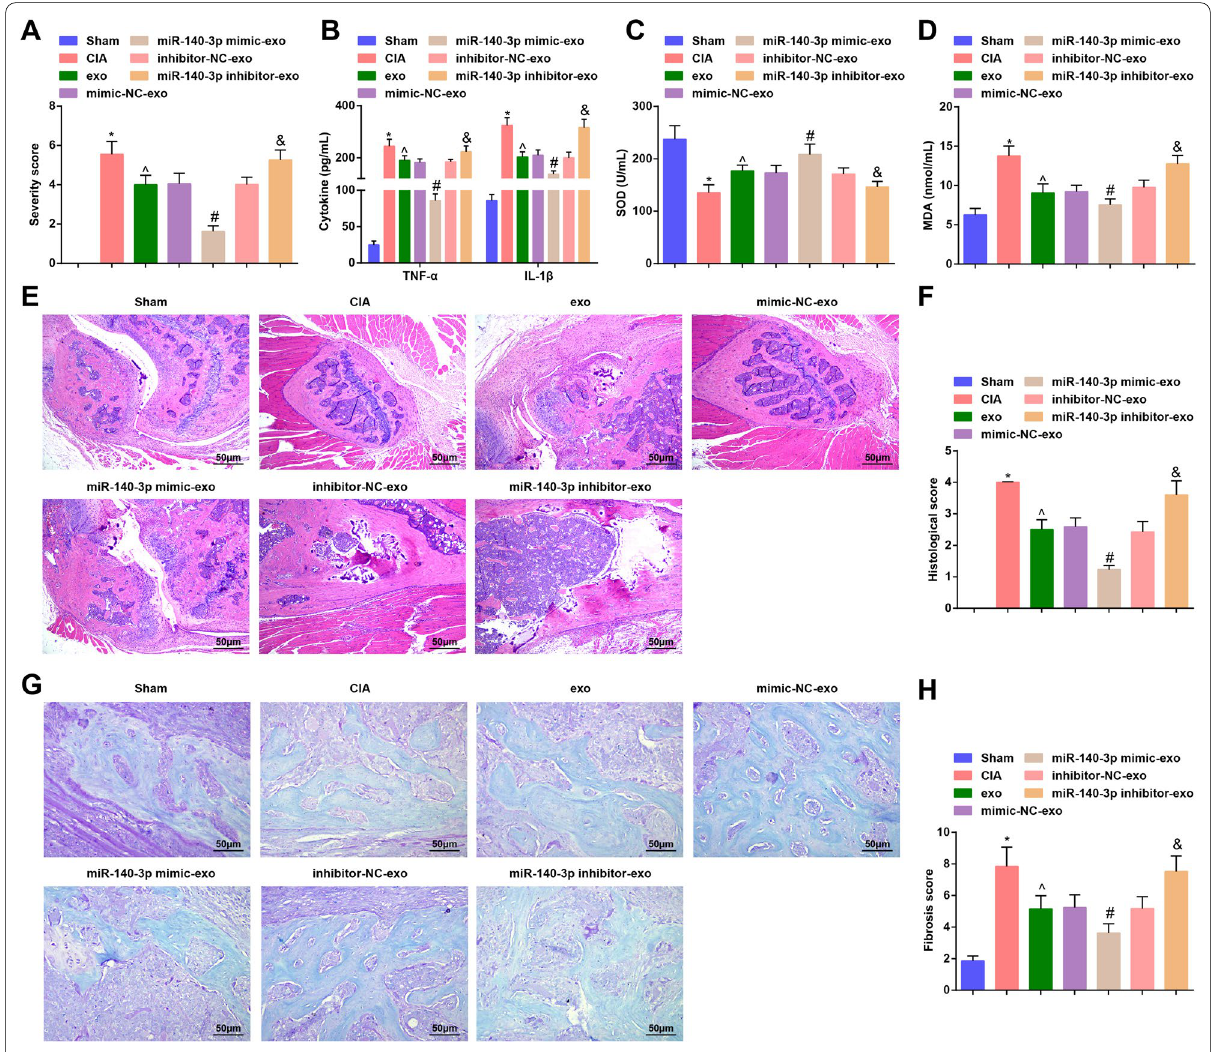
Fig. 2 HUCMSCs-exo or exosomal miR-140-3p attenuates joint injury of RA rats and reduced miR-140-3p reverses the effect of HUCMSCs-exo on joint injury of RA rats. A Pathological changes in rat feet; B Serum contents of TNF-α and IL-1β in rats; C Serum activity of SOD in rats; D Serum content of MDA in rats; E Pathology of rat ankle joints was observed through HE staining; F RA score of rats after HE staining; G Masson staining was used to observe the fibrosis in tibial articular cartilage of rats; H Fibrosis was quantified based on Masson staining; n sham group, ^ P < 0.05 vs the CIA group, # P < 0.05 vs the mimic-NC-exo group, & P < 0.05 vs the inhibitor-NC-exo group; the data were expressed as mean standard deviation, ANOVA was used for comparisons among multiple groups and Tukey’s post hoc test was used for pairwise comparisons ± after